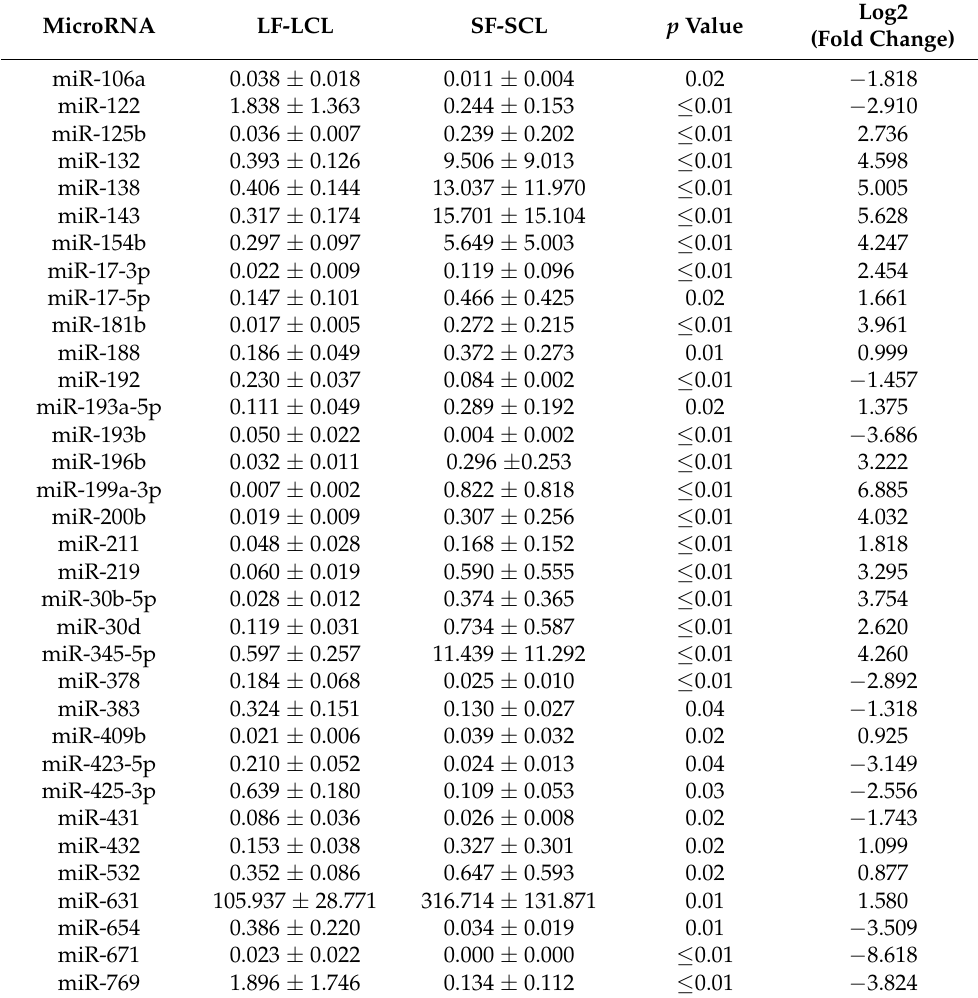
Table 2. Relative abundance of differentially expressed microRNAs in the isthmus of LF-LCL and SF- SCL groups ( n = 10). Fold changes were the ratio of the mean expression values of